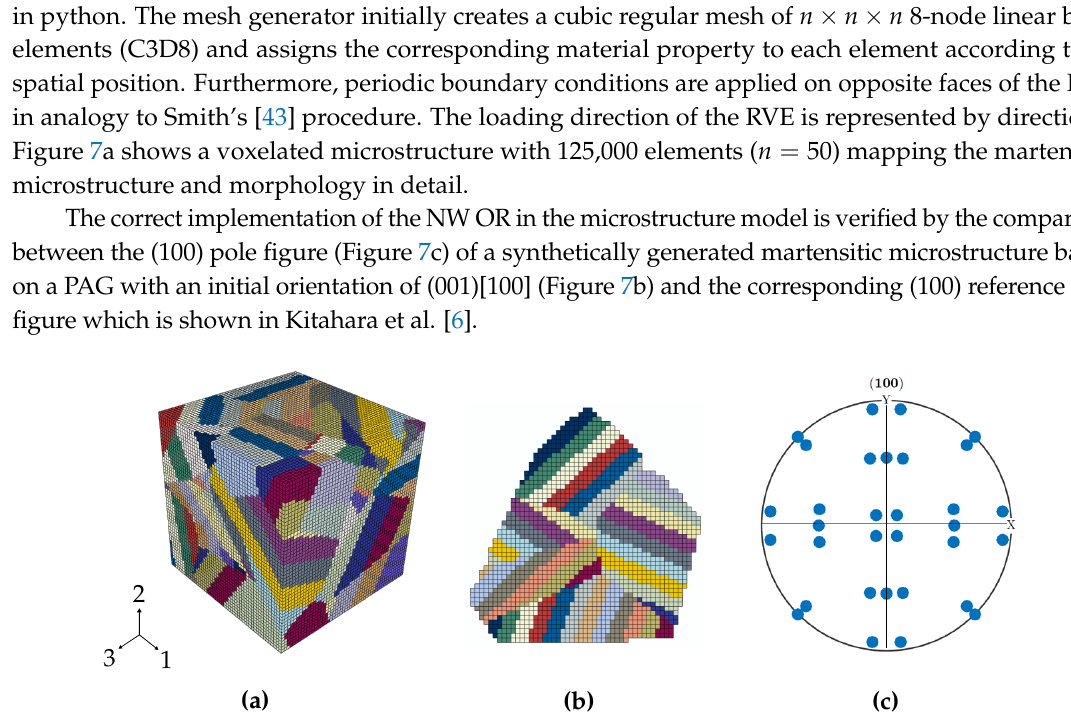
Figure 7. Three-dimensional synthetic martensitic microstructure: ( a ) Representative volume element with 125,000 elements ( b ) two-dimensional representation of a transformed PAG with an initial orientation of (001)[100] ( c ) (100) pole figure of Figure